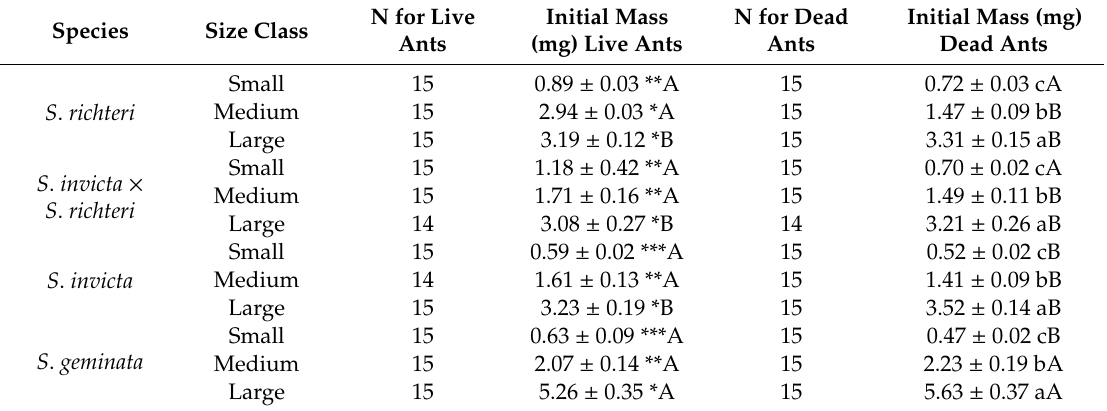
Table 2. Initial mass (mg) of small, medium, and large live and dead workers of S . invicta , S . richteri , S . invicta × S . richteri, and S . geminata ants (mean ± SE). N for Live Initial Species Size Class Ants